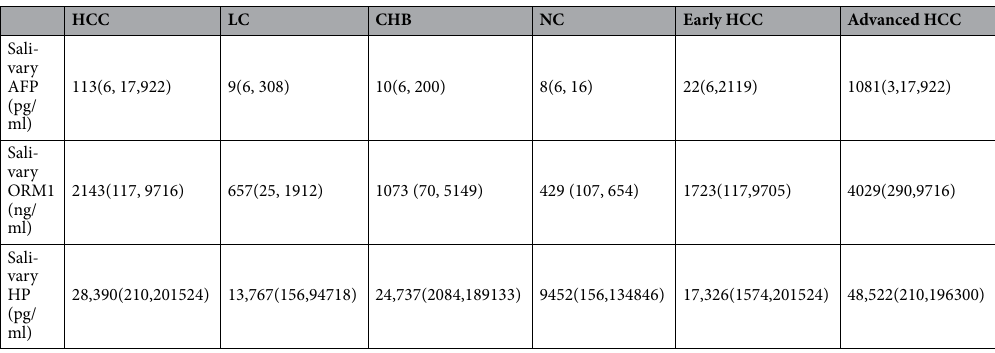
Table 4. The expressions of Salivary AFP, ORM1 and HP in each group. The quantitative variables of the non-normal distribution were represented by median (range). Abbreviations: NC normal control, CHB chronic